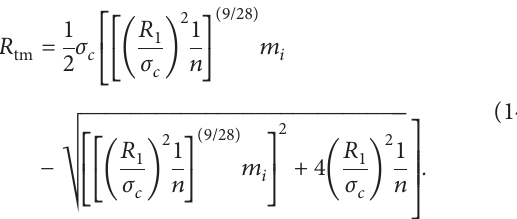
b and s with porosity.